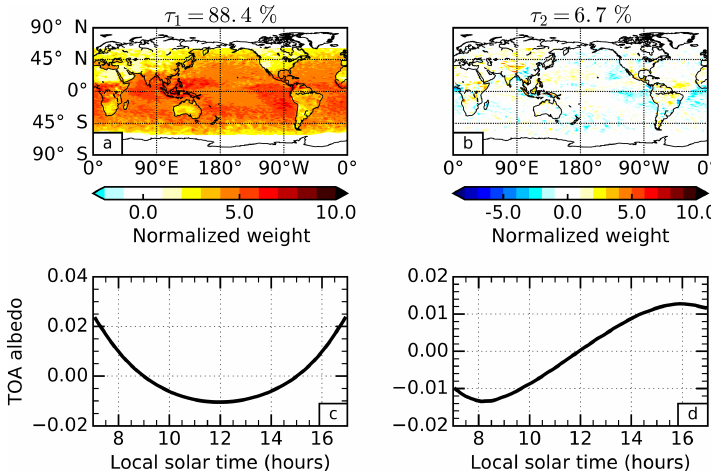
Figure 4. Same as Fig. 1, but for the top-of-atmosphere (TOA) albedo.